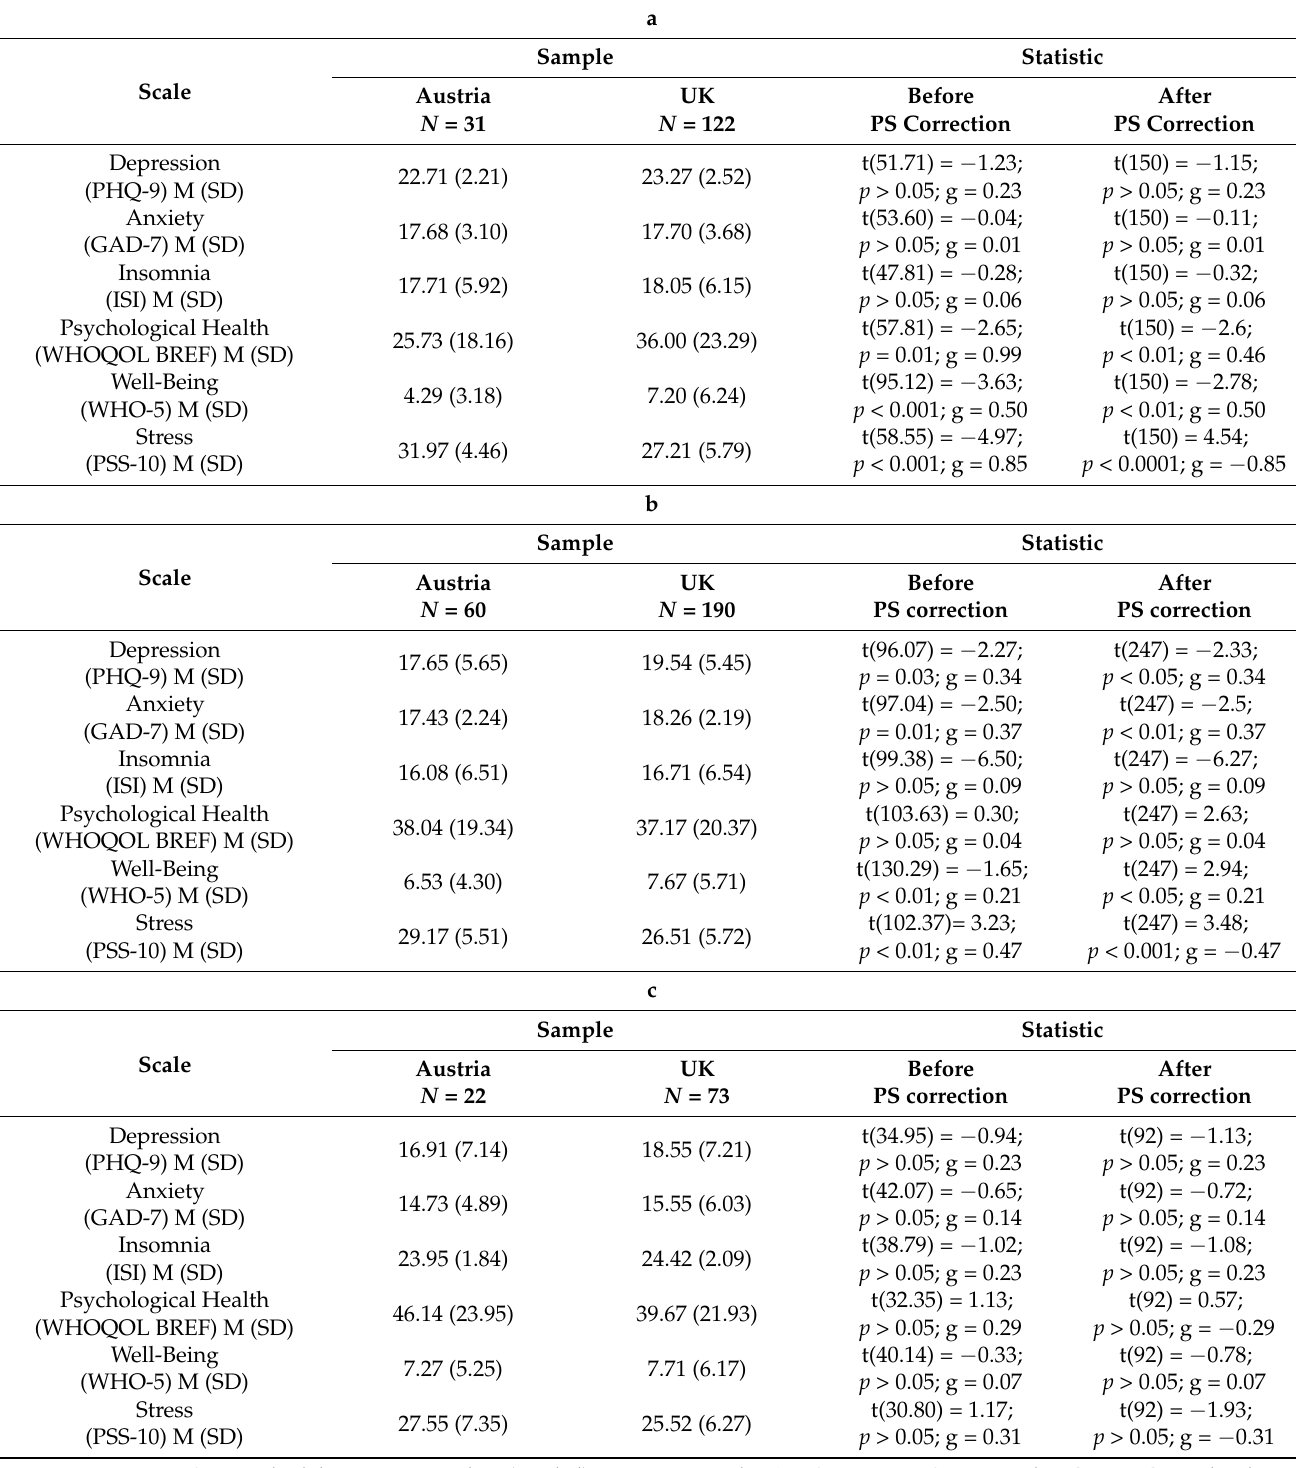
Table 2. Comparisons between continuous mental health scores of Austrian and UK samples in those with severe PHQ9 depressive symptoms. b. Comparisons between continuous mental health scores of Austrian and UK samples in those with severe GAD-7 anxiety symptoms. c. Comparisons between continuous mental health scores of Austrian and UK samples in those with severe ISI insomnia